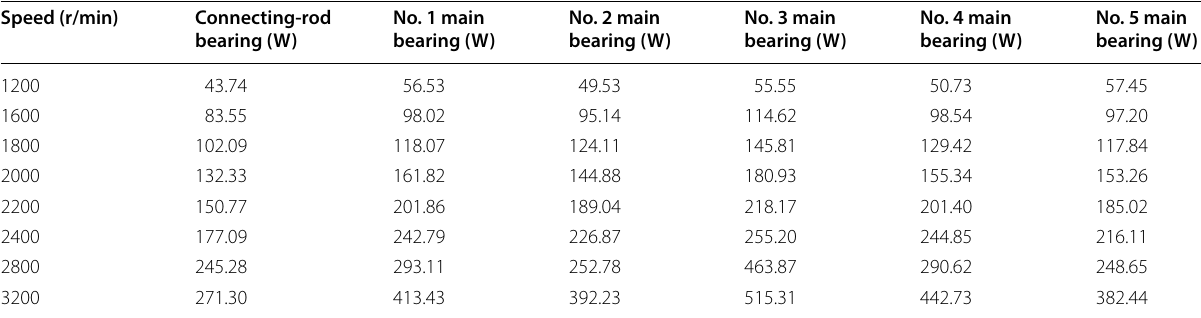
Table 6 Average friction power losses of connecting‑rod bearing and main bearings at full load and different speed Speed (r/min)